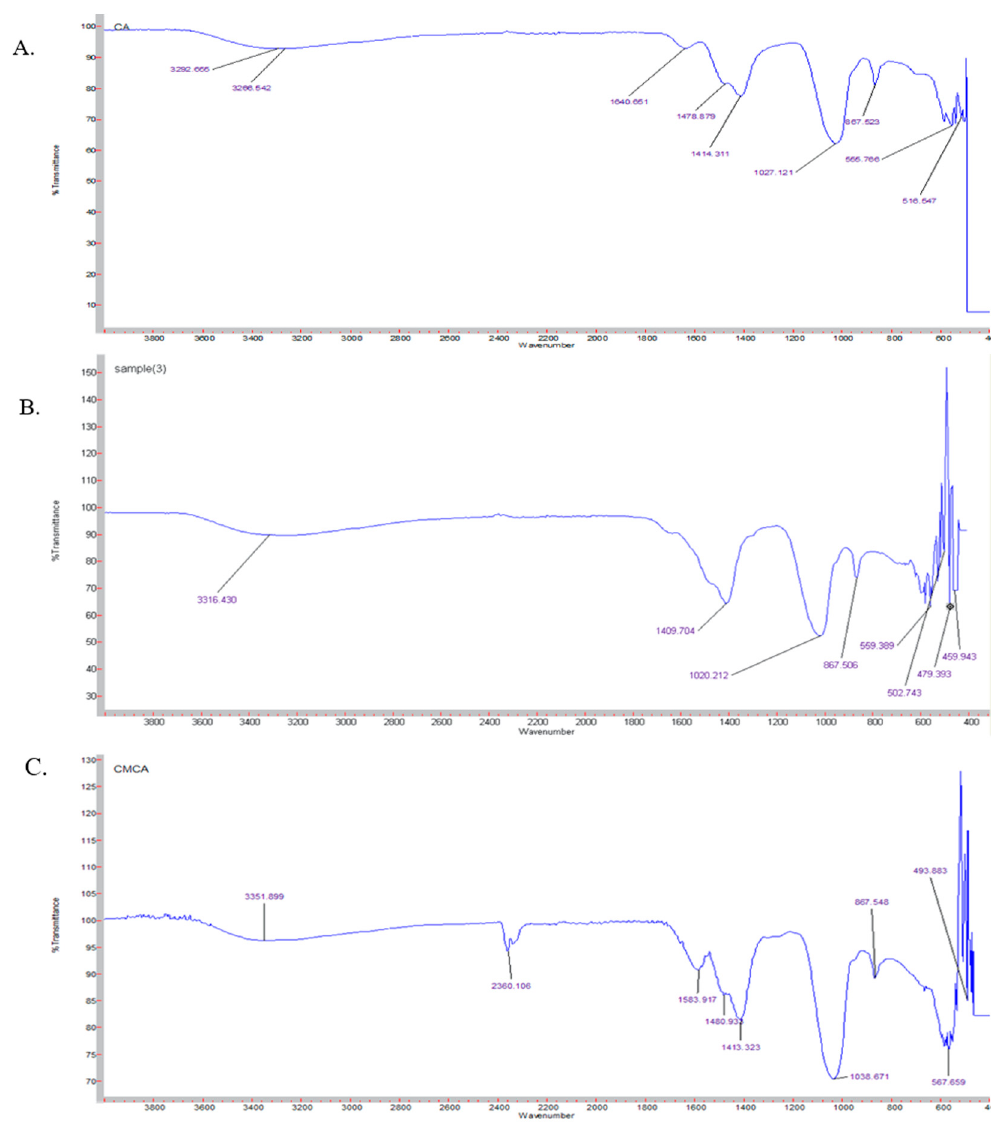
Figure 15. The FTIR spectrum. ( A ) the FTIR spectrum of CA NPs; ( B ) the FTIR spectrum of SMCA NPs; ( C ) the FTIR spectrum of CMCA NPs.